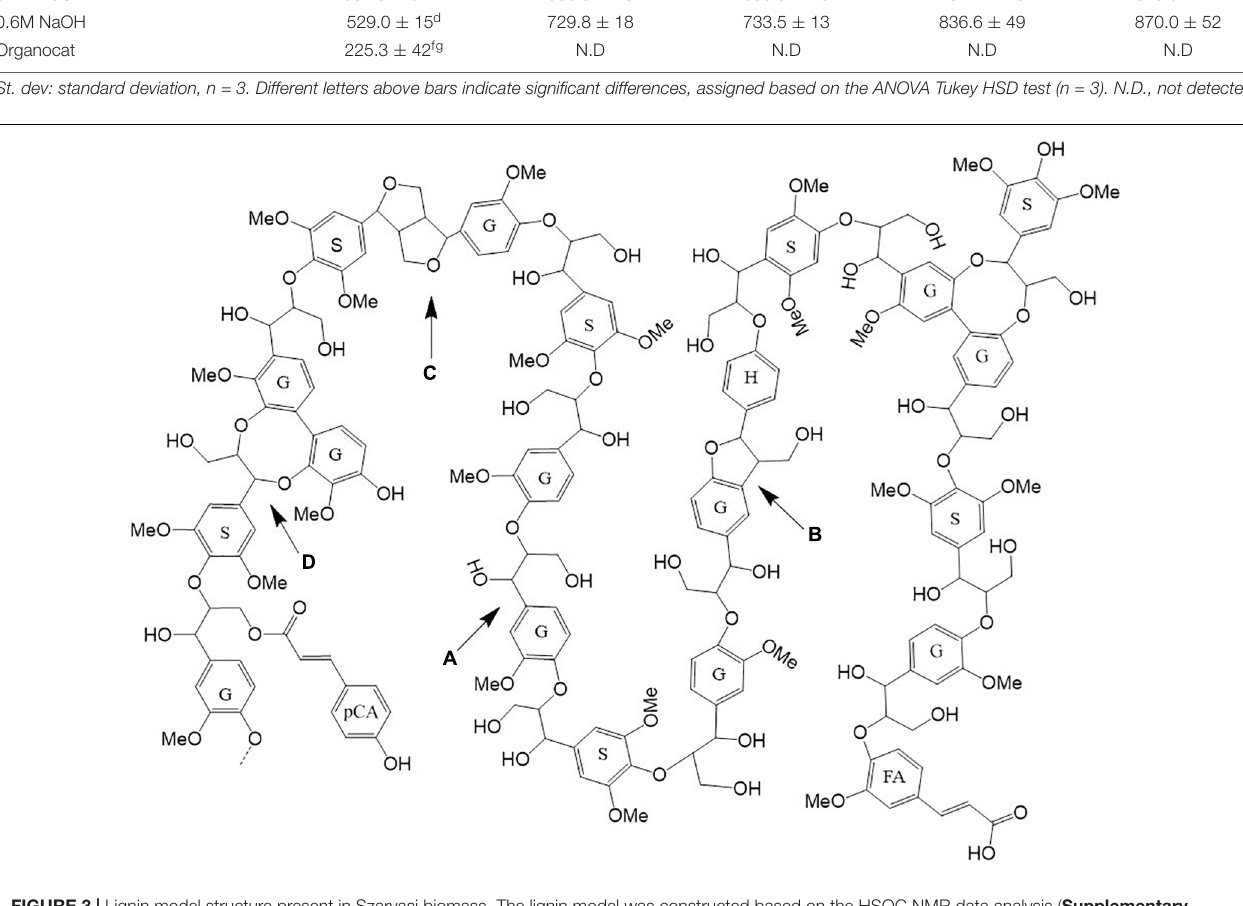
FIGURE 3 | Lignin model structure present in Szarvasi biomass. The lignin model was constructed based on the HSQC NMR data analysis ( Supplementary Table 1 ). Lignin monomers: S, syringyl; G, guaiacyl; H, p-hydroxyphenyl; FA, ferulate; p CA, p -coumarate. Lignin linkages: A, β -aryl ether; B, phenylcoumaran; C, resinol; D, dibenzodioxocin